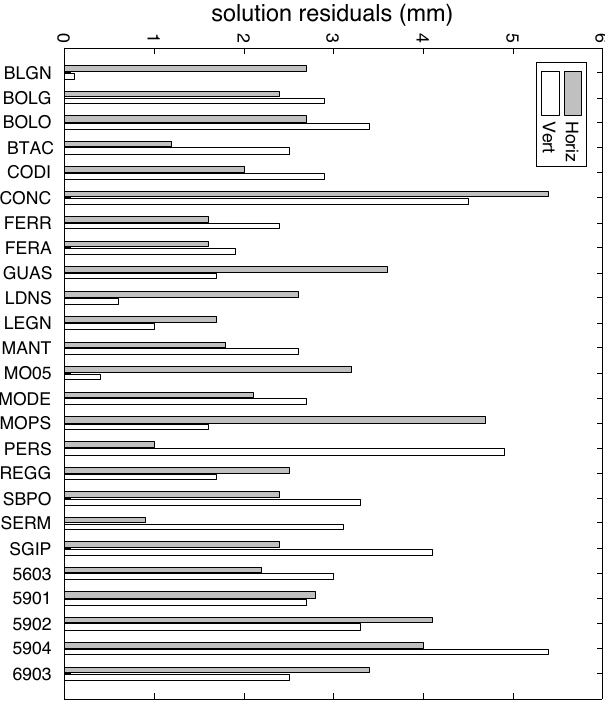
Figure 4. Cumulative WRMS of the station offset differences between the individual May 29, 2012, solutions (BERNESE, GAMIT and GIPSY) for the horizontal (gray) and vertical (open bar)